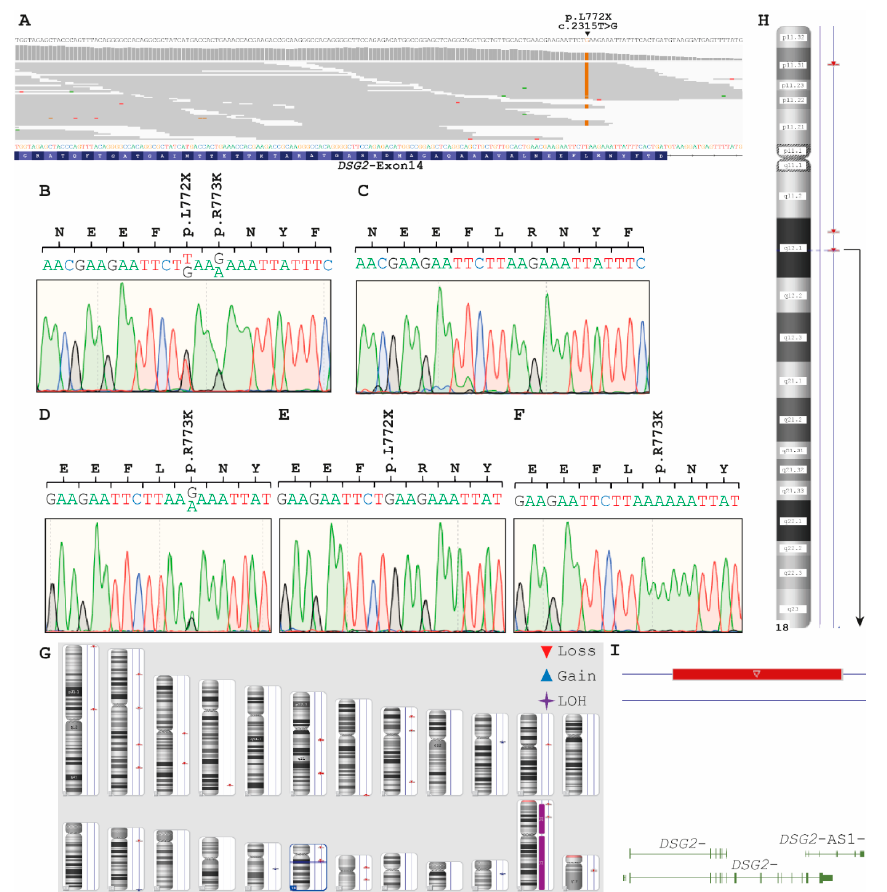
Figure 7. (A–I) Genetic analysis of Family B. (A) Integrated genome view of exon 14 in DSG2 of patient II-2 (Family B). (B–F) Partial electropherograms of DSG2 exon 14 revealed for I-1 two heterozygous variants p.L772X and p.R773K (B) , for I-2 a wild-type sequence (C) , for II-1 the heterozygous variant p.R773K (D) , for II-2 hemizygous p.L772X (E), and for II-3 hemizygous p.R773K (F) . (G) Karyoview of II-2 (Family B). LOH = loss of heterozygosity. (H–I) Detailed ideogram of human chromosome 18 revealing an additional deletion on the second chromosome affecting nearly the complete DSG2